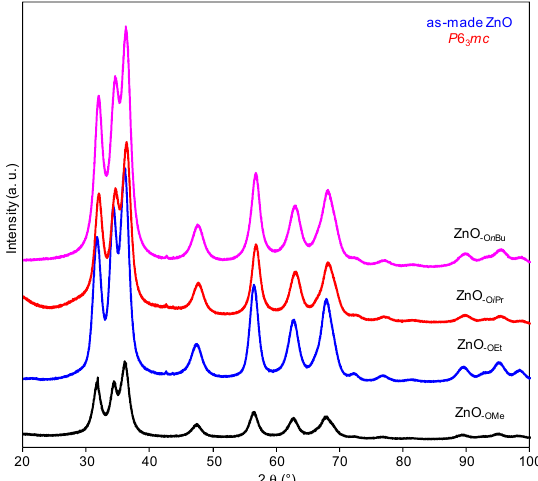
Figure 6. Wide-angle PXRD patterns of as-made ZnO -OR NPs derived from directly thermal decomposition of fresh-prepared Zn(OR) 2 (R = Me, Et, i Pr and n Bu) in the presence of oleylamine at 240 °C for 2 h.